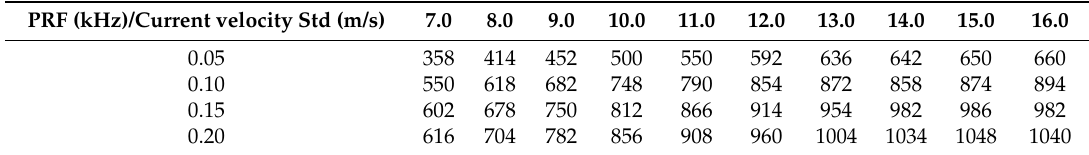
Figure 19. Current velocity components Std with PRF for a wind speed of 7 m/s and a wind direction of 90 ◦ : ( a ) along-track direction; ( b ) cross-track direction. Table 9. Current field effective swaths of different current velocity Stds with different values of PRF. PRF (kHz)/Current velocity Std